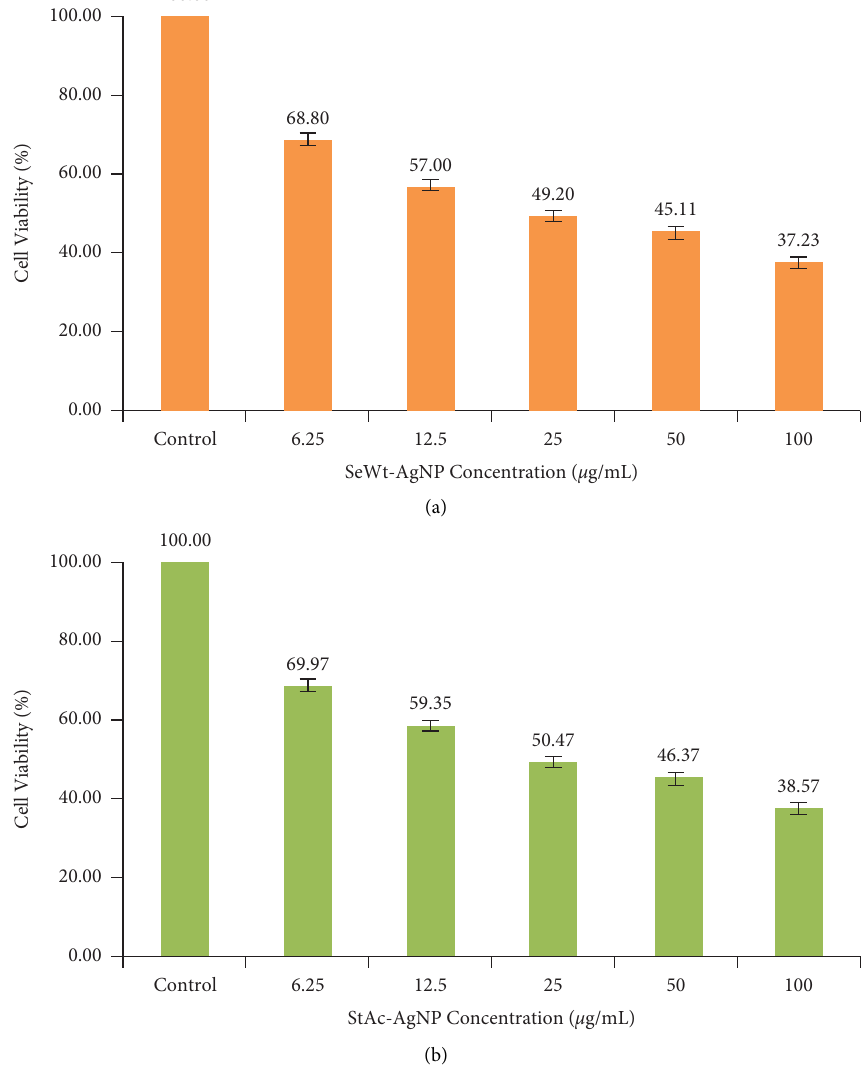
Figure 10: MCF-7cell viability after treatment with varied AgNP concentrations of (a) SeWt-AgNPs and (b)